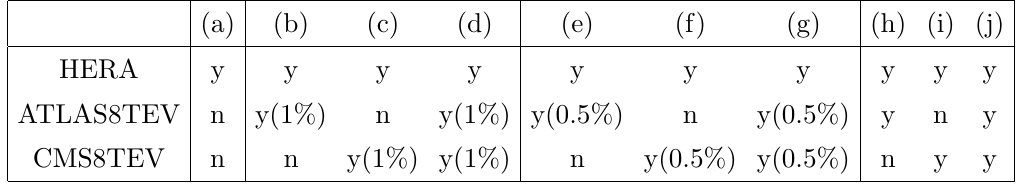
Table 5 . Overview of (cid:12)ts run with HERA-only as a baseline. For each (cid:12)t, we indicate which measurements from ATLAS and CMS has been included, whether an uncorrelated uncertainty has been added to the (cid:31) 2 (in brackets unless it is set to